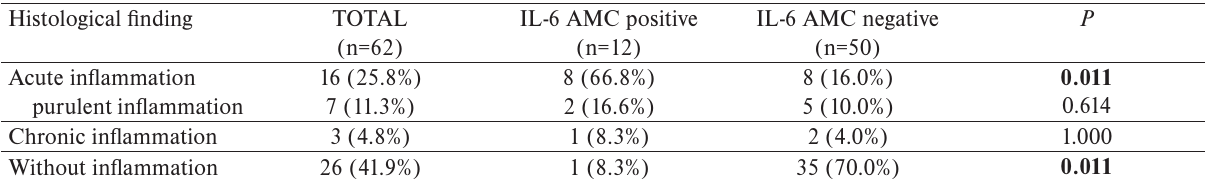
Table 5. Placental histopathology in women with